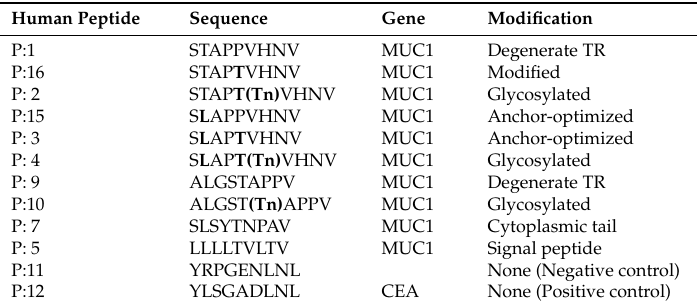
Table 1. List of MUC1 and control peptides for